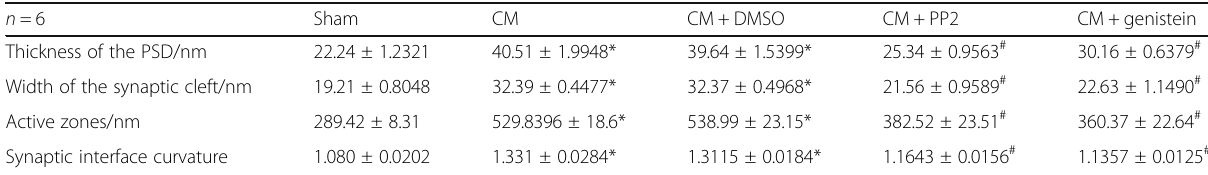
Table 2 Parameters of the synaptic interface in each of the five groups in the TNC of CM rats n = 6 Sham CM